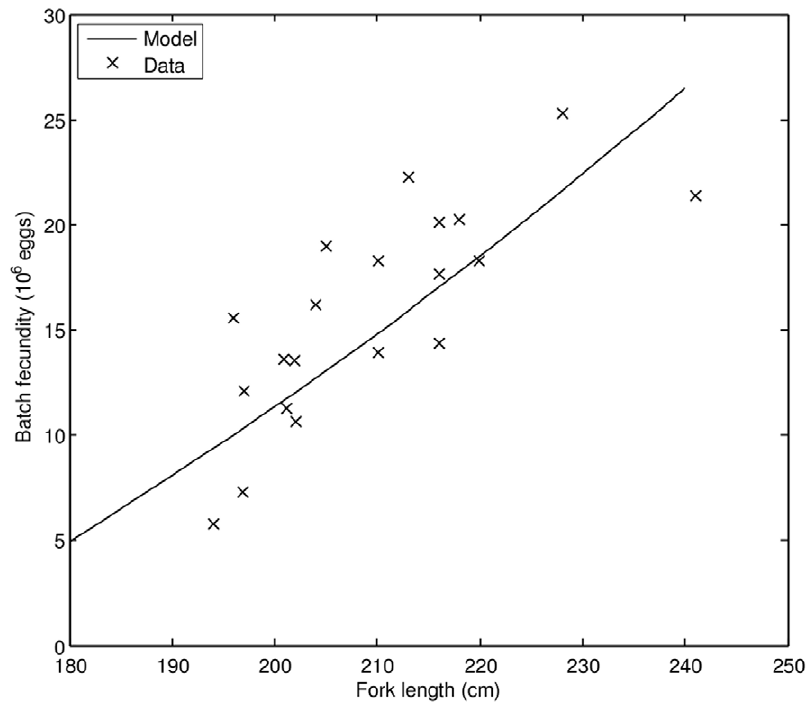
Figure 8. Batch fecundity as a function of fork length; comparison of model results to observations (data source: [ 44 ] ).